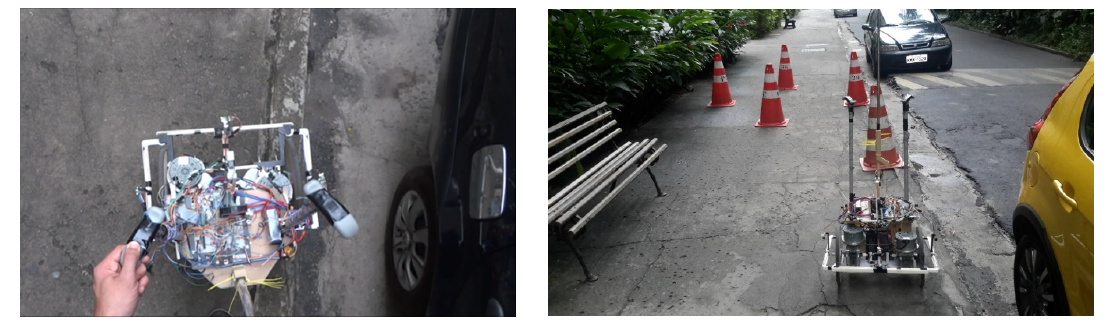
Figure 18. Route 1 observation points.